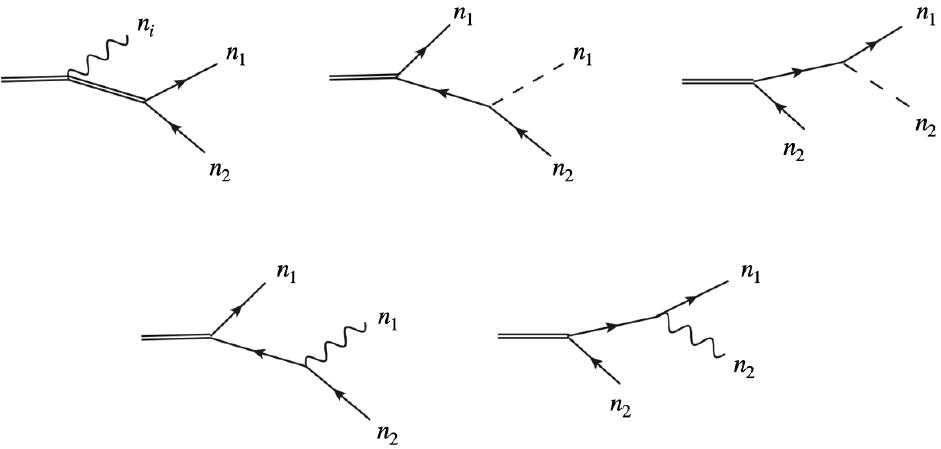
Figure 5 . Tree-level Feynman diagrams needed for the calculation of the matching conditions for the Wilson coefficients of the subleading-power two-jet operators for the leptoquark U 1 . A double line represents the leptoquark, a dashed line a Higgs boson, and a wavy line a SM gauge boson. The final-state particle moving along n 1 is a quark, while the particle moving along n 2 is a lepton. The gauge boson in the first diagram can move along either